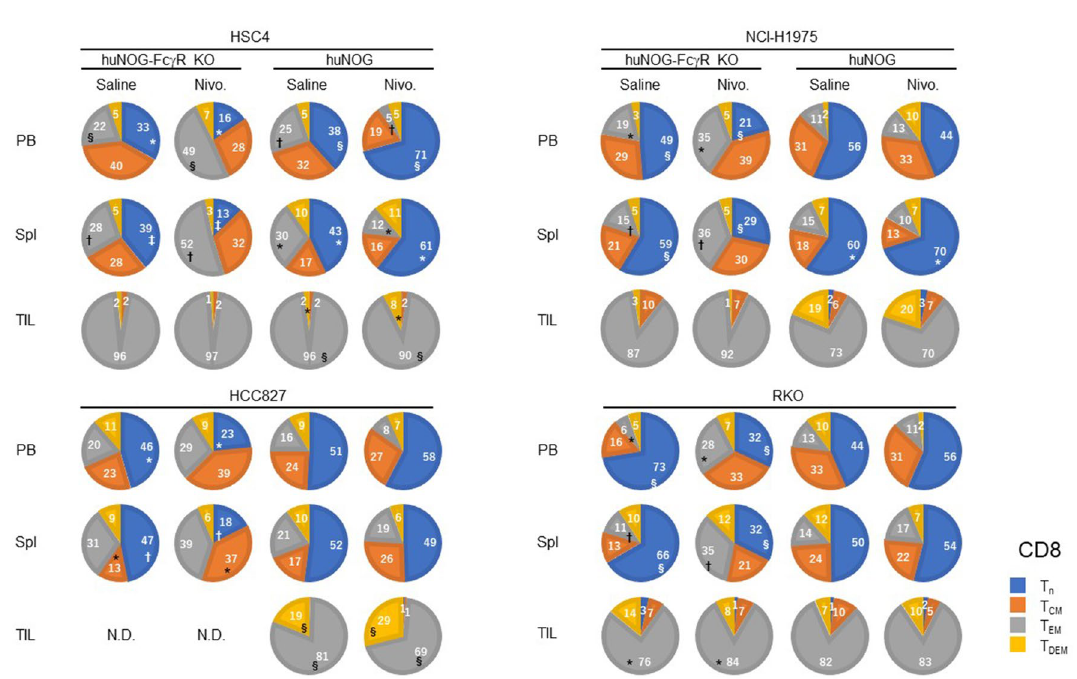
Figure 8. Alternations of CD8 + T cell subsets by nivolumab in huNOG-FcγR −/− mice. The proportions of CD8 + T cell subsets were obtained from flow cytometry analyses in Fig. 7. The results of the frequencies (Supplementary Fig. 12) and cell numbers (Supplementary Fig. 13) of the T-cell subpopulations are summarized in the pie charts, as in Fig. 7. Statistical significance was tested using two-way ANOVA with Sidak’s multiple comparison test (*p < 0.05, † p < 0.01, ‡ p < 0.001, § p <